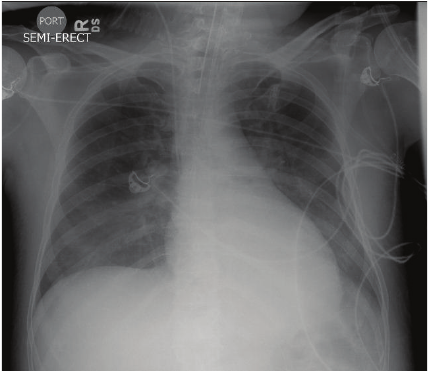
Figure 3: Follow-up CXR showing near resolution of bilateral infil-